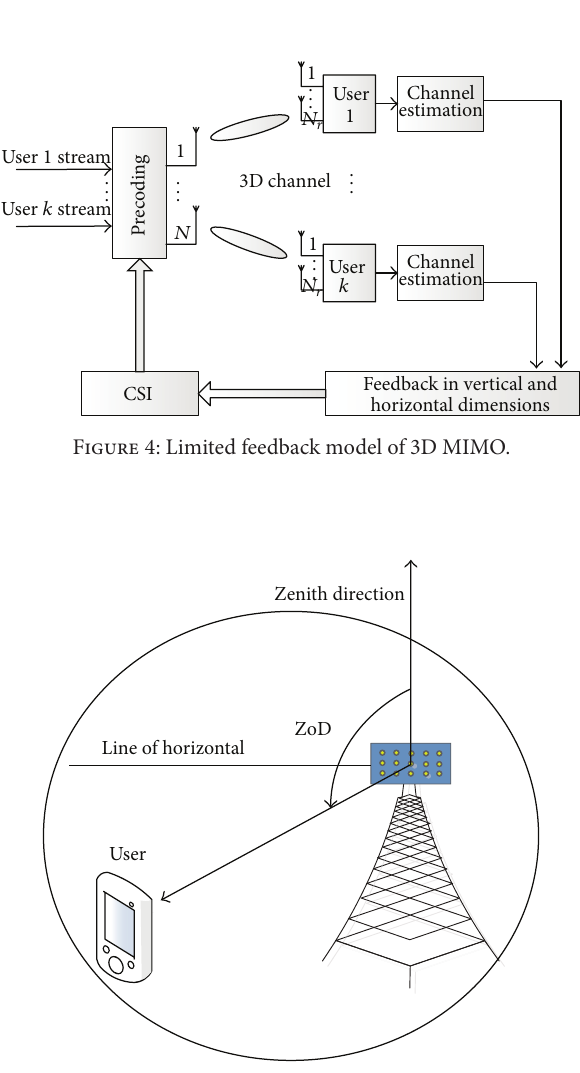
Figure 3: The CDF of ZSD in 3D-UMa and 3D-UMi scenarios.